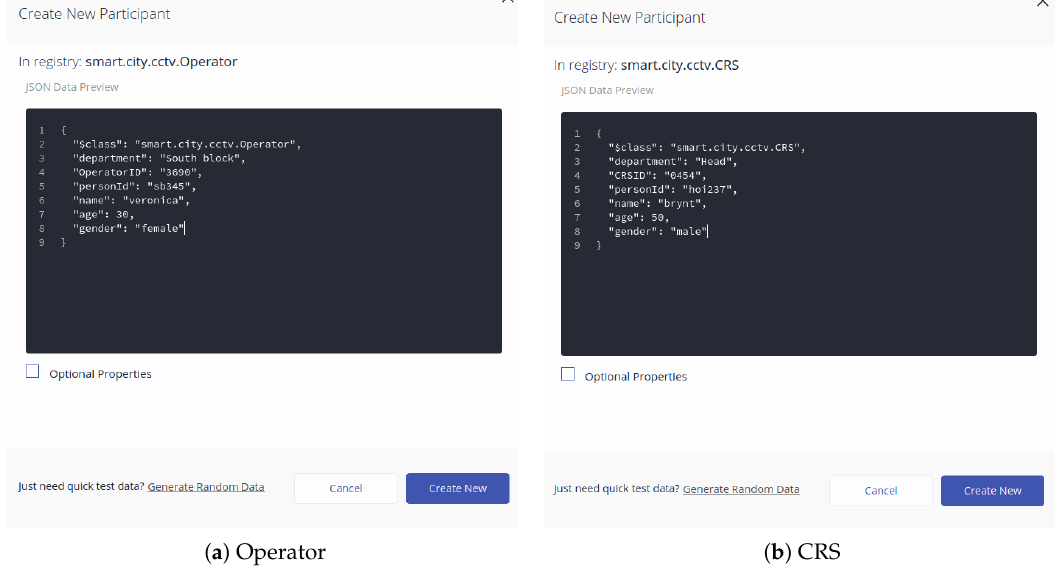
Figure 9. Add new